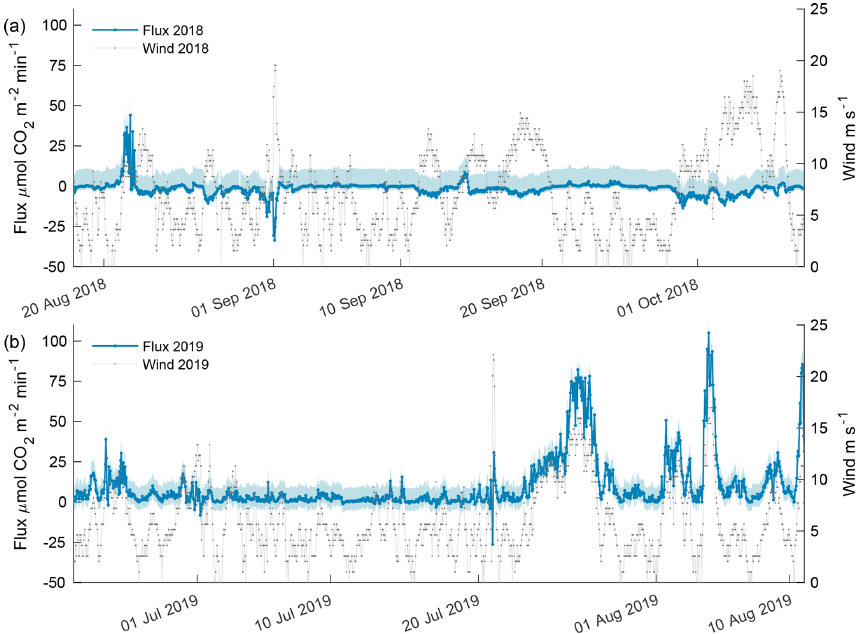
Figure 9. Estimated carbon flux (orange) and wind speed (gray) for the 2018 open phase (a) and 2019 open phase (b) . Estimated flux potential is shaded in blue where the upper bound is associated with the difference in p CO 2 from the A T –salinity insitu regression, and the lower bound is associated with freshwater Schmidt number. The upper and lower bounds for the 2018 open phase were 10.67 and 2.23µmolCm − 2 min − 1 while 2019 open-phase upper and lower bounds were 8.56 and 5.52µmolCm − 2 min − 1 , respectively.